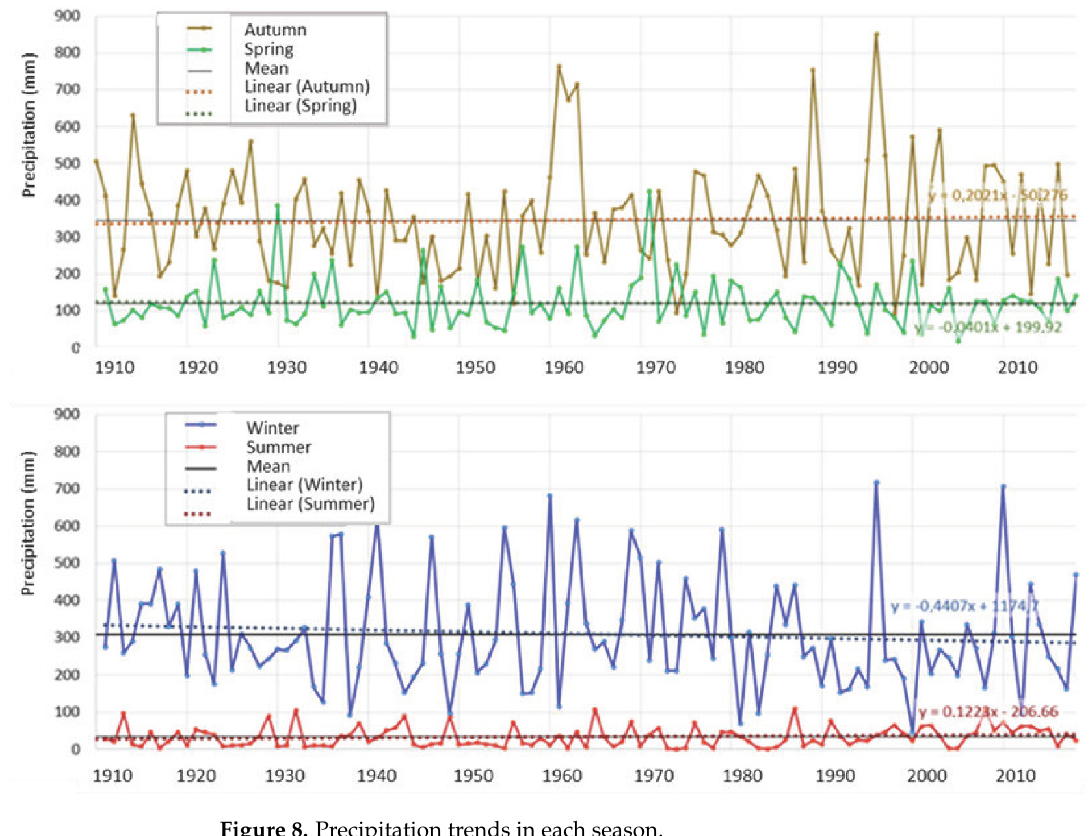
Figure 8. Precipitation trends in each season.